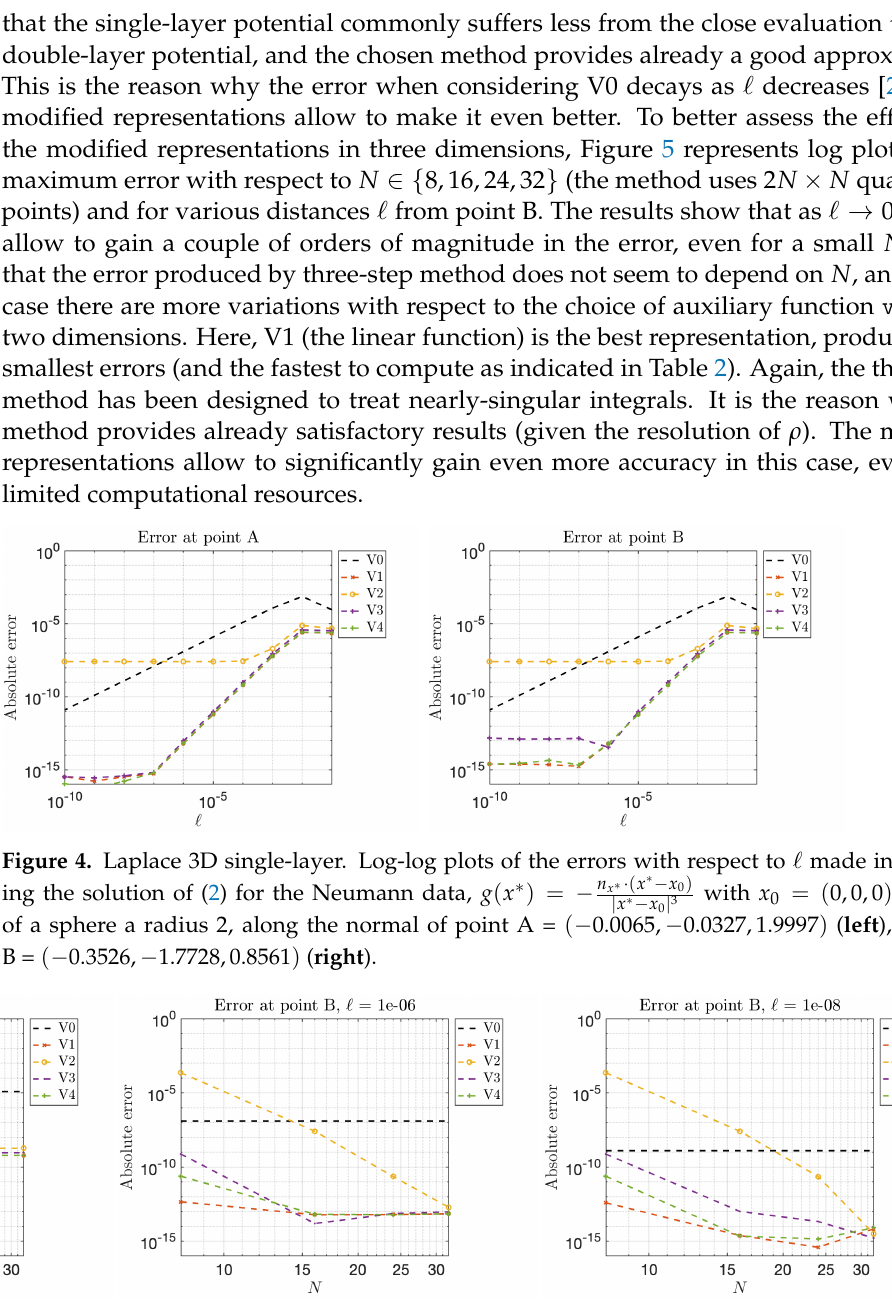
Figure 5. Laplace 3D single-layer. Log-log plots of the errors with respect to N made in computing the solution (as described in Figure 4) at some distance (cid:96) along the normal from point B = ( − 0.3526, − 1.7728,0.8561 ) . Table 2. Laplace 3D single-layer. CPU times (in seconds) for various number of quadrature points and representations for computing the solution (as described in Figure 4) from points A and B,